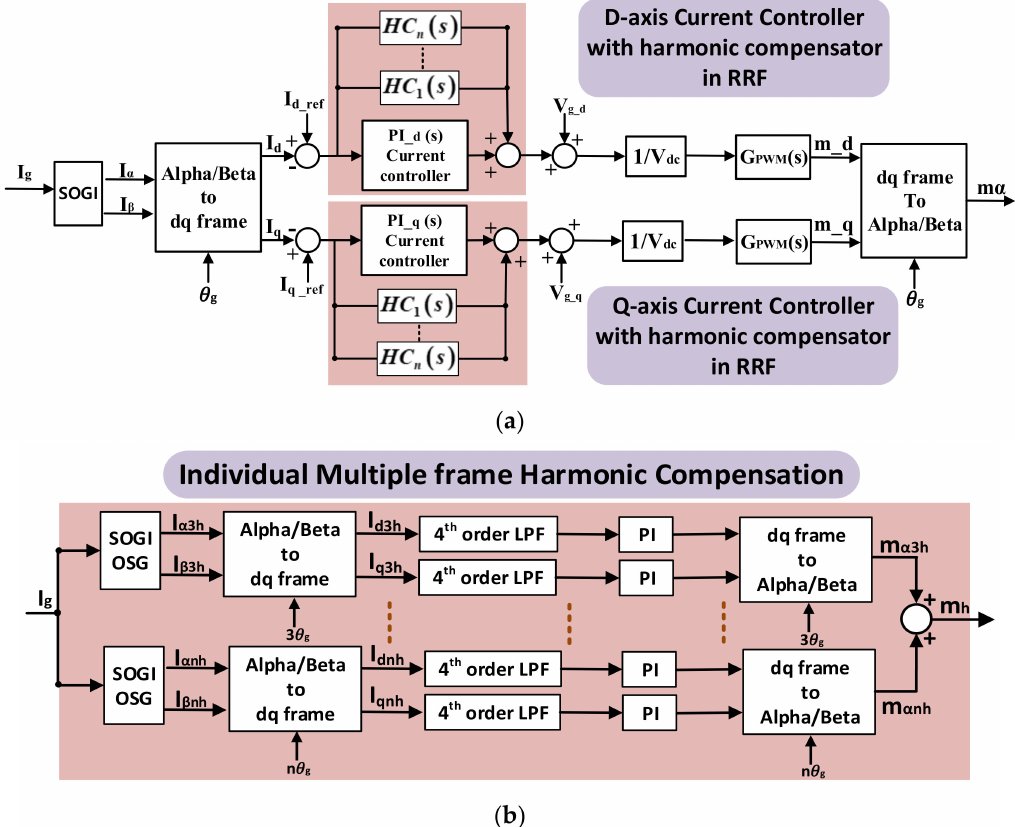
Figure 1. Conventional harmonic compensation methods in RRF: ( a ) Method I [21–28]; ( b ) Method II